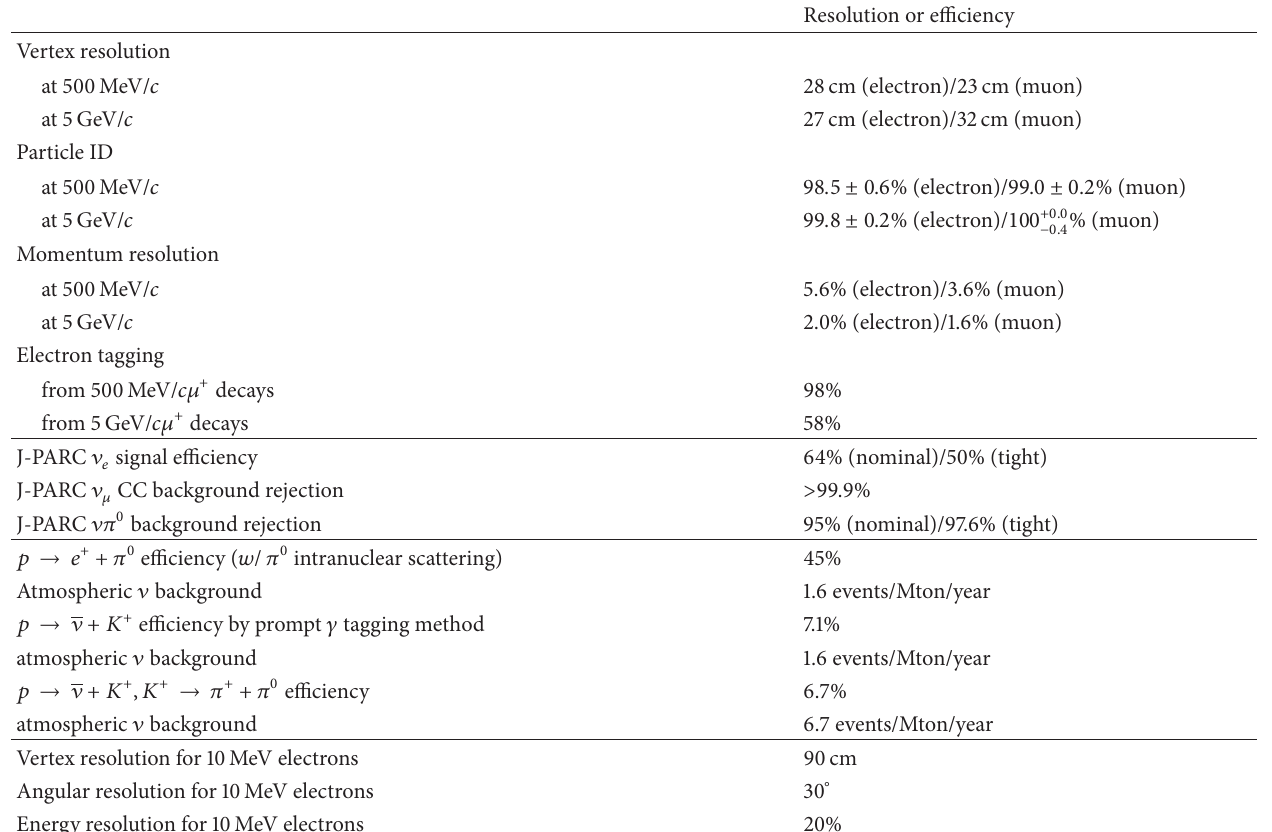
Table 7: Expected detector performance of